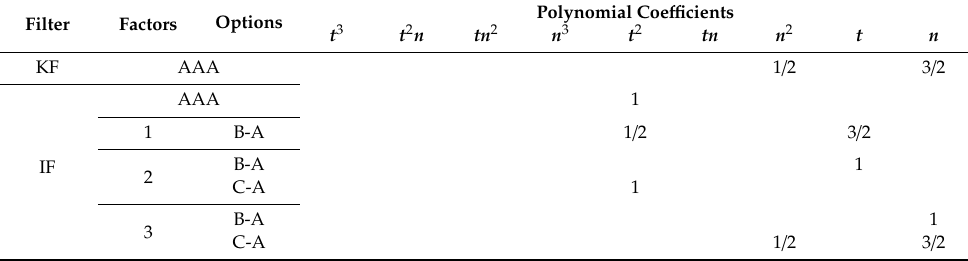
Table 6. Polynomial coe ffi cients of scalar division